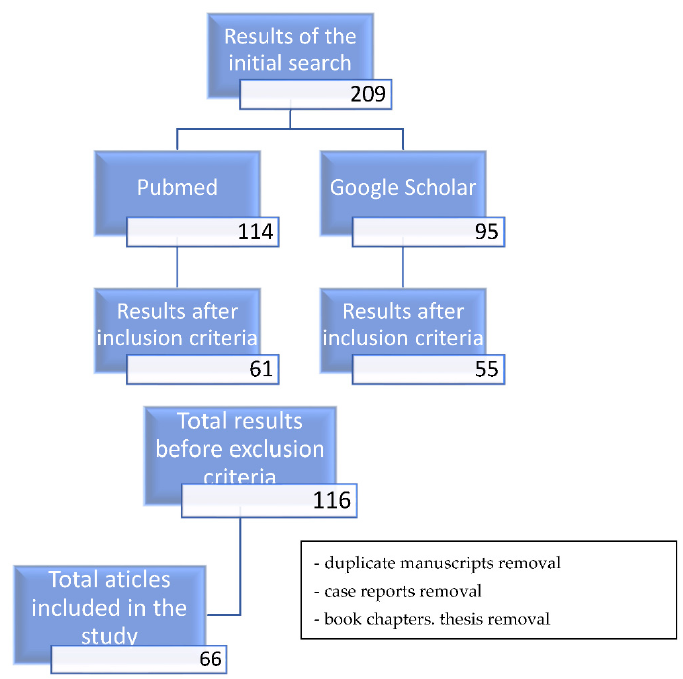
Figure 1. Results of the study selection.